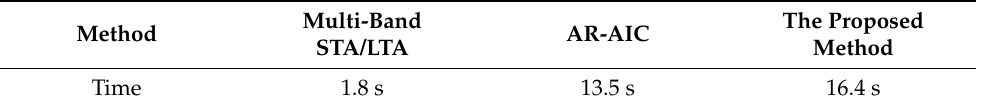
Table 2. Comparison of the computational cost for the three different methods.